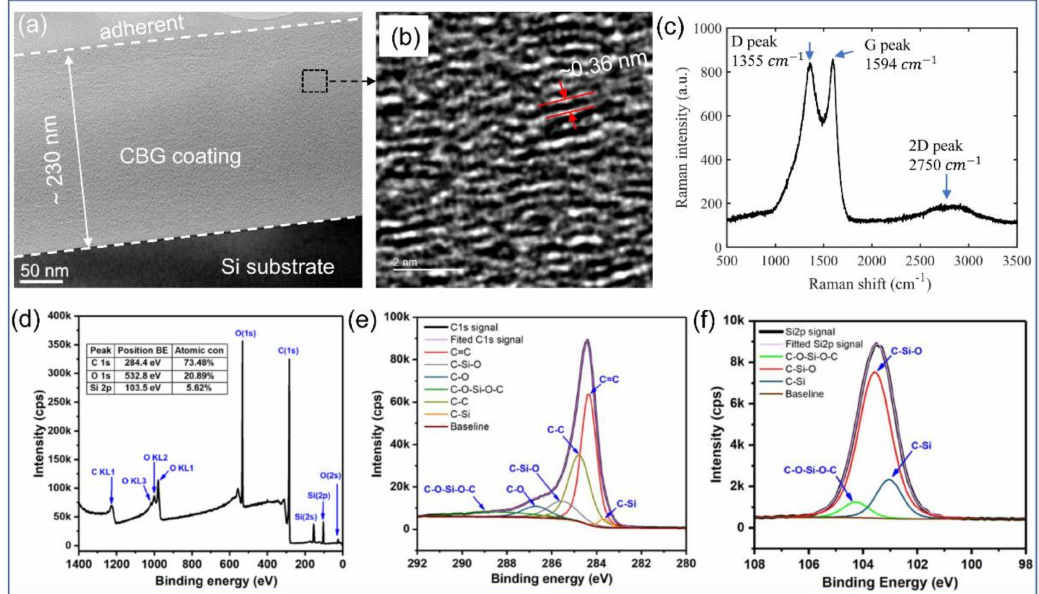
Figure 7. Characterizations of the CBG coating: ( a ) HRTEM image across the cross-section of the silicon mold insert, ( b ) higher magnification HRTEM image of a small region in ( a ), ( c ) Raman spectrum, ( d ) overall XPS spectrum analysis, ( e ) C 1s spectrum and ( f ) Si 2p